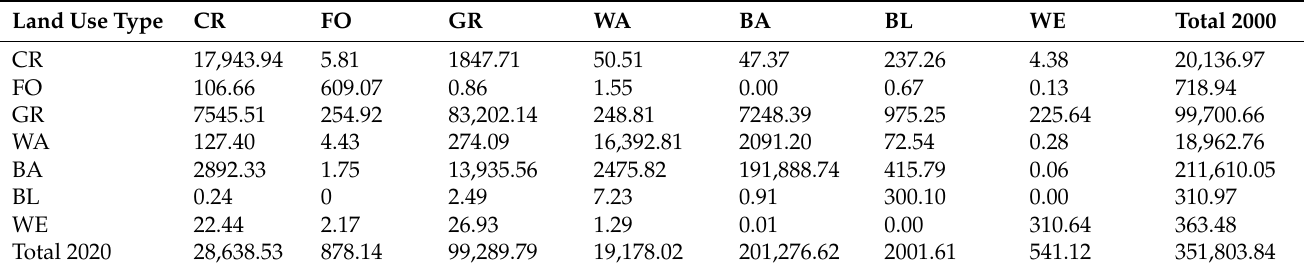
Table 4. LUCC Transfer Matrix of the TRB (km 2